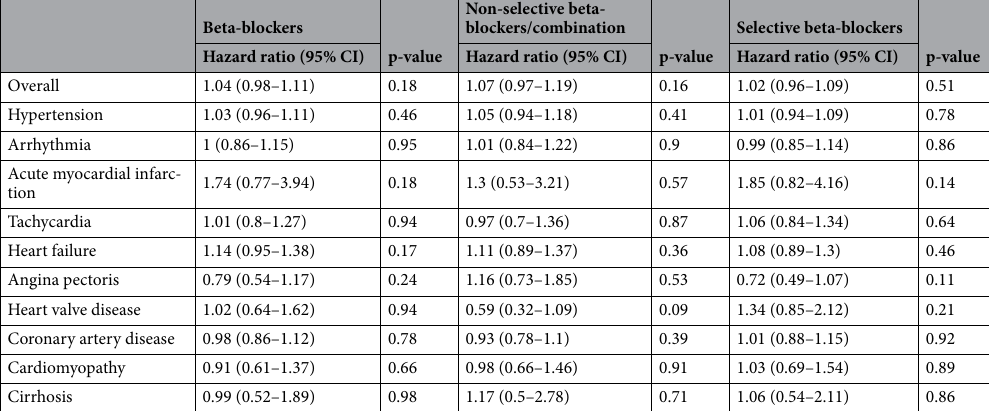
Table 4. Cox-Proportional Hazards model for beta-blockers, non-selective beta-blockers/combination (included concurrent usage of selective and non-selective beta-blockers) and selective beta-blockers prior to diagnosis stratified by condition, adjusted for tumor stage, cancer-directed surgery, radiation therapy, chemotherapy and propensity score. Propensity score included sex, age, marital status, race, income and Charlson comorbidity score. Reference for each group includes all other patients not using the specified